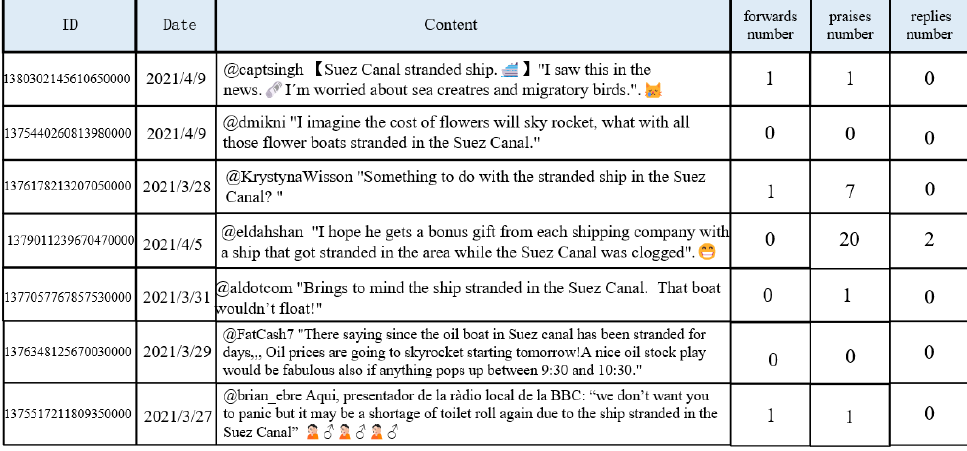
Figure 3. Some online reviews about